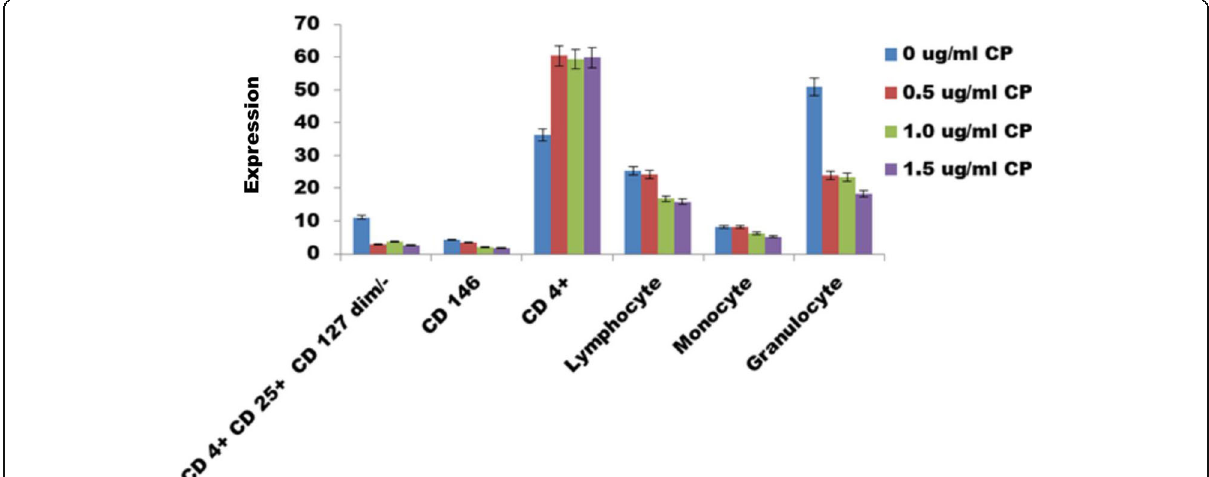
Fig. 1 Methanol extract of Calotropis procera leaf reduced CD146 expression on blood cells at 24 h. CP was used on the blood cells and we discovered that it reduced the expression of CD146, increased the expression of CD4+ and dose dependent. It shows that CP may be an